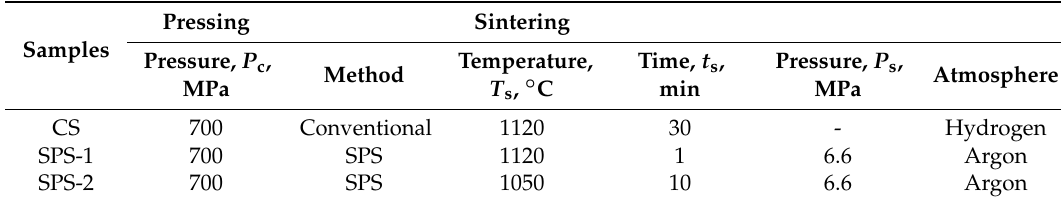
Table 3. The designation of products and the applied technological parameters. CS: conventional sintering; SPS: spark plasma sintering method.